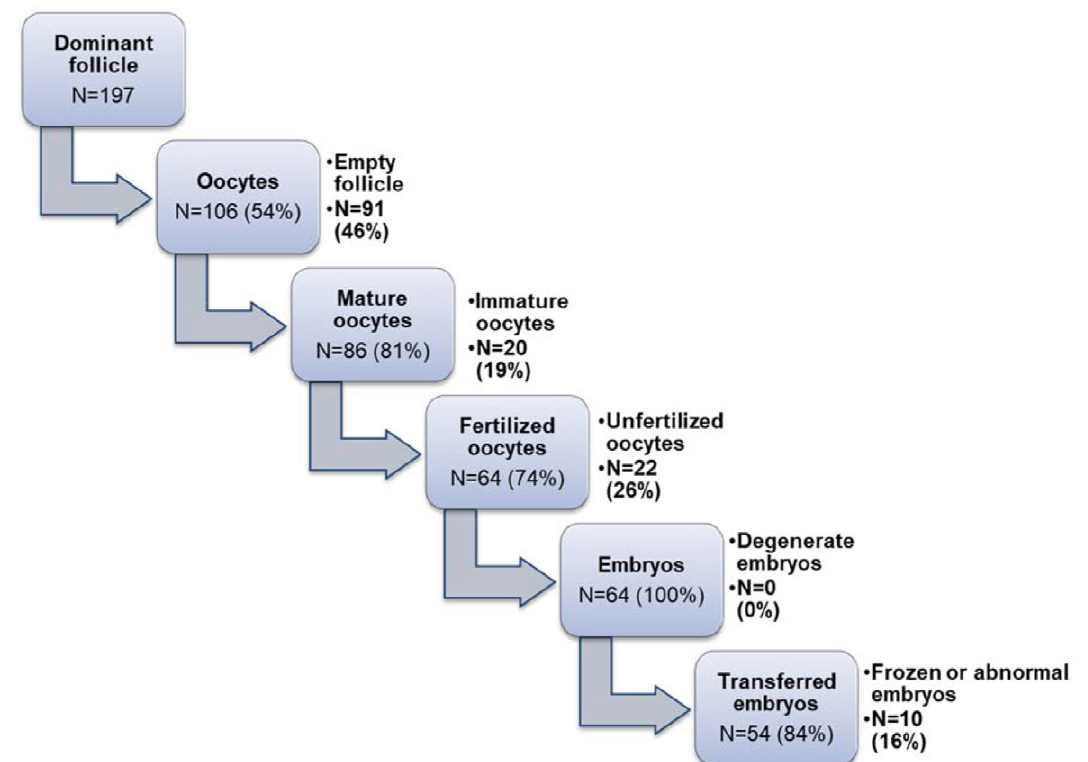
Figure 1: Outcome of IVF procedure in patients enrolled in the study by